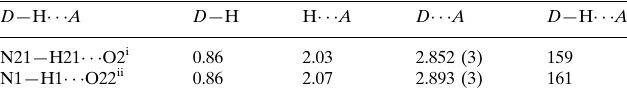
Hydrogen-bond geometry (A˚ , (cid:1)